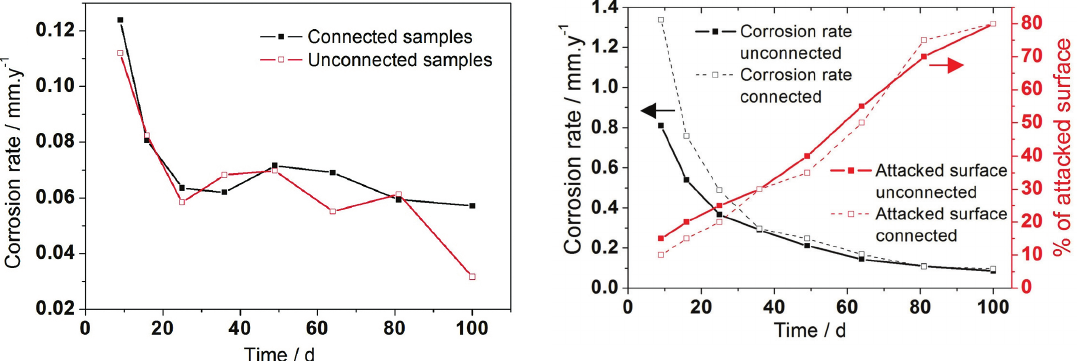
Figure 6. Mean corrosion rate during exposure time per attacked surface and percentage of attacked surface versus total exposure